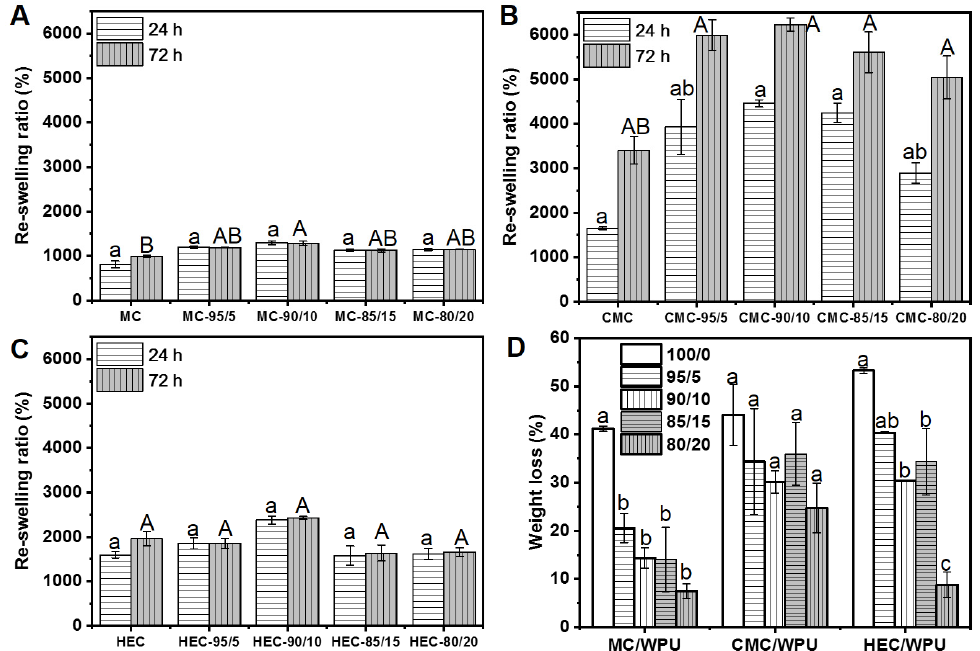
Figure 5. ( A – C ) Reswelling ratio of cellulose/WPU composite aerogels. ( D ) Weight loss of cellu- lose/WPU composite aerogel after water immersion. ( A – C ) Different letters indicate significant differences in reswelling time at the 0.05 level obtained by Tukey’s test and analysis of variance (ANOVA). Different letters indicate significant differences between addition ratios of WPU in the same cellulose material at the 0.05 level obtained by Tukey’s test and analysis of variance (ANOVA). The letters of 24 h and 72 h are marked as “a and b” and “A and B”, respectively.